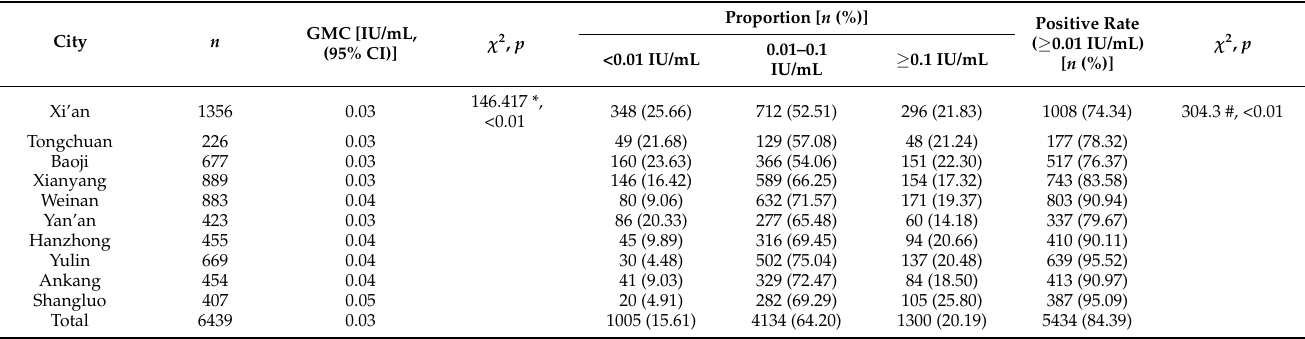
Table 2. Seroprevalence and tetanus antibody level in different